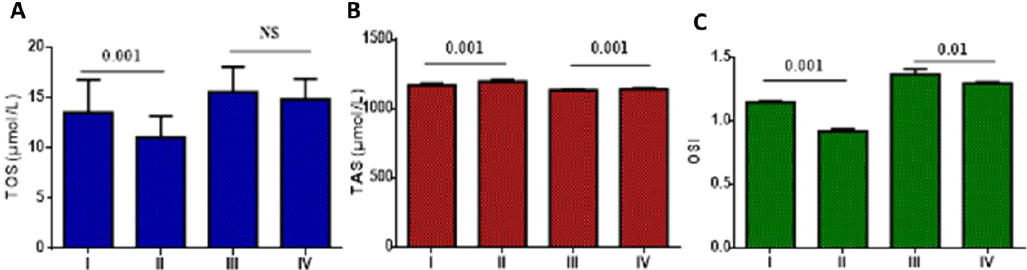
Figure 5. Effects of metformin monotherapy versus metformin plus sitagliptin treatment on the oxidative stress in T2DM patients with COVID-19: I: T2DM patients on metformin with mild-moderate COVID-19, II: T2DM patients on metformin plus sitagliptin with mild-moderate COVID-19, III: T2DM patients with severe COVID-19 on metformin monotherapy, IV: T2DM patients with severe COVID-19 on metformin plus sitagliptin. ( A ): TOS: total oxidant status; ( B ): TAS: total antioxidant status; ( C ): OSI: oxidative stress index. Table 5. Metformin effects versus metformin plus sitagliptin on anthropometric and biochemical variables in T2DM patients with COVID-19.